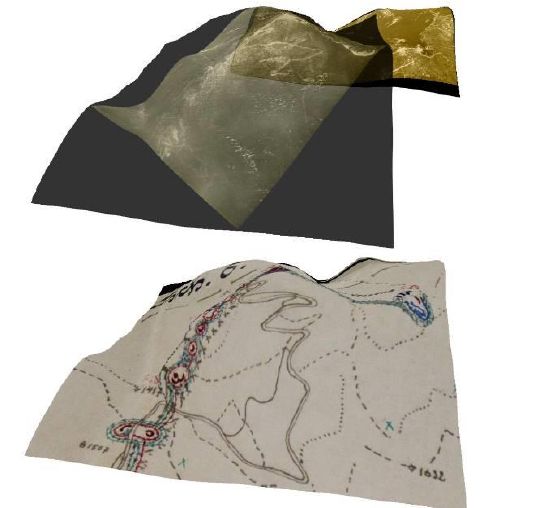
Figure 3 . Georeferencing of historical documentations original pixels, preferring, depending on the case, global or local processes of geometric transformation. The geometric transformations applicable to a cartographic image can be classified into two categories: global and local transformations.